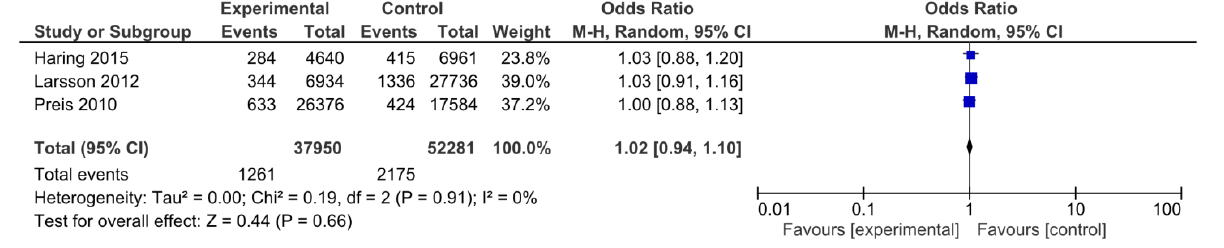
Figure 4. Forest plot for the association between HP intake and risk of non-fatal stroke. [15,51,56].